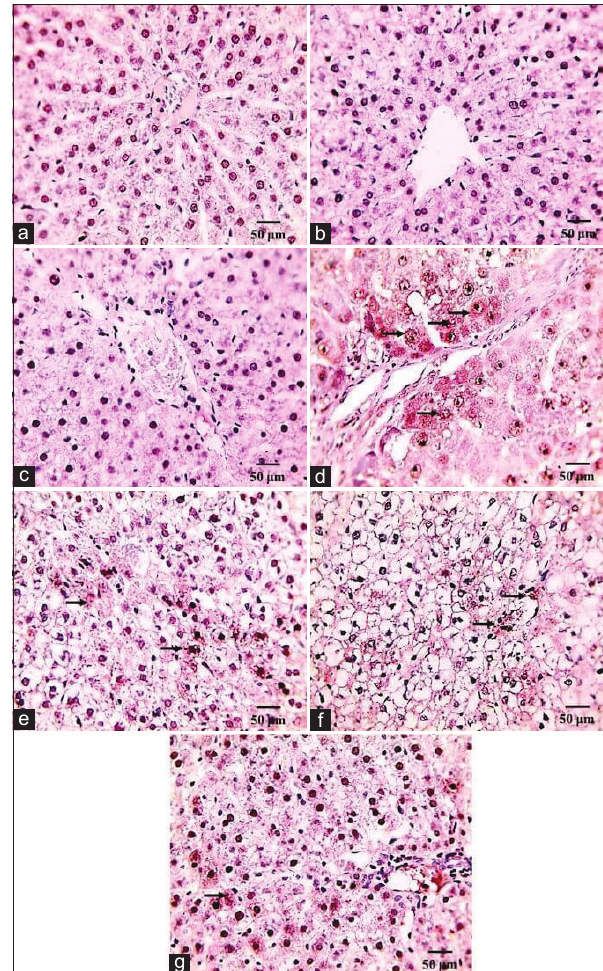
Figure-3: Light photomicrographs of hepatic tissues (sections stained with H and E). (a-c) Normally organized hepatic lobules consisted of radially arranged hepatic cords around central veins with normal sinusoids and portal areas. (d) Disorganization of hepatic cords (black asterisk) with the formation of broad fibrous septa separating the hepatic lobules and infiltrated with leukocytic cells (black arrow), besides congested blood vessels (black arrow head) and dilated lymphatics. In addition, the hepatocytes showing focal coagulative necrosis (red asterisk). (e) Mild congestion of the central veins (arrowhead) and mild diffuse hydropic degeneration of hepatocytes (black asterisk). (f) Mild congestion of central veins (arrowhead) and severe diffuse hydropic degeneration of hepatocytes (red asterisk). (g) Normal organization of hepatic cords and normal central veins. (a) Control, (b) sitagliptin (Sit), (c) losartan (LOS), (d) fipronil (FPN), (e) Sit-FPN, (f) LOS- FPN, (g) Sit-LOS-FPN scale bar =100 µ